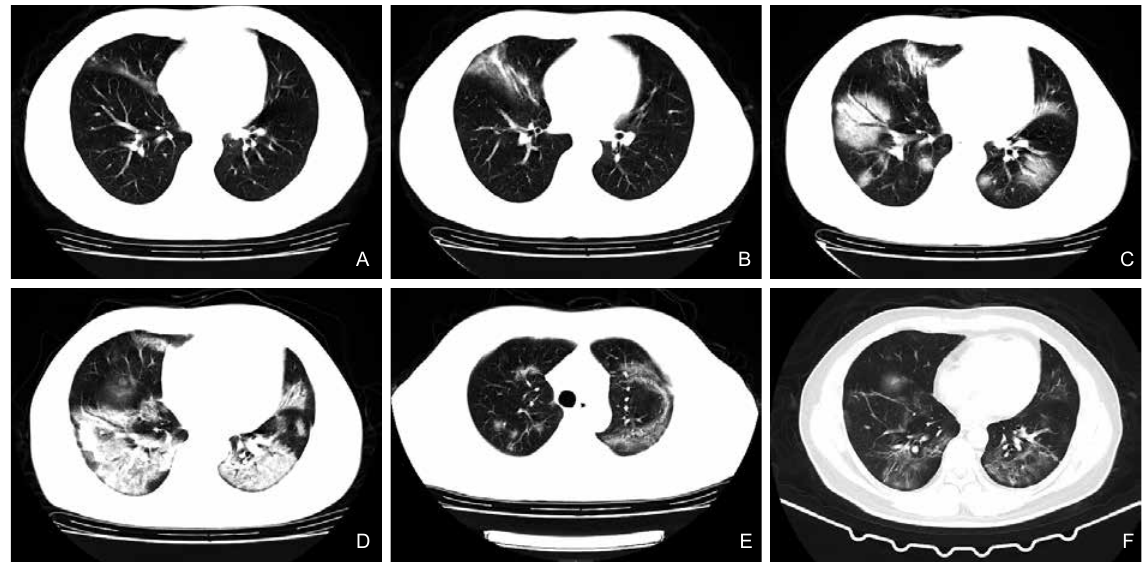
A B Figure 5 A 36-year-old man who had close contact history with COVID-19 pneumonia patients in indigenous group presented with fever and vomiting. (A) Initial CT scan at 2 days after admission showed ground glass opacity in subpleural regions of right middle lung. (B) CT image obtained at 5 days after admission displayed that the lesion in right middle lung expanded and opacity increased. (C) CT images obtained at 8 days after admission showed apparent bilateral patchy ground-glass opacities. (D) CT images obtained at 11 days after admission displayed obvious consolidative pulmonary opacities with air bronchogram sign. (E) The lesions shrunk after 15 days in the hospital and there appeared irregular line opacity. (F) The extent of lesions was further lessened with the trend of absorption and dissipation on CT images obtained at 18 days after admission.